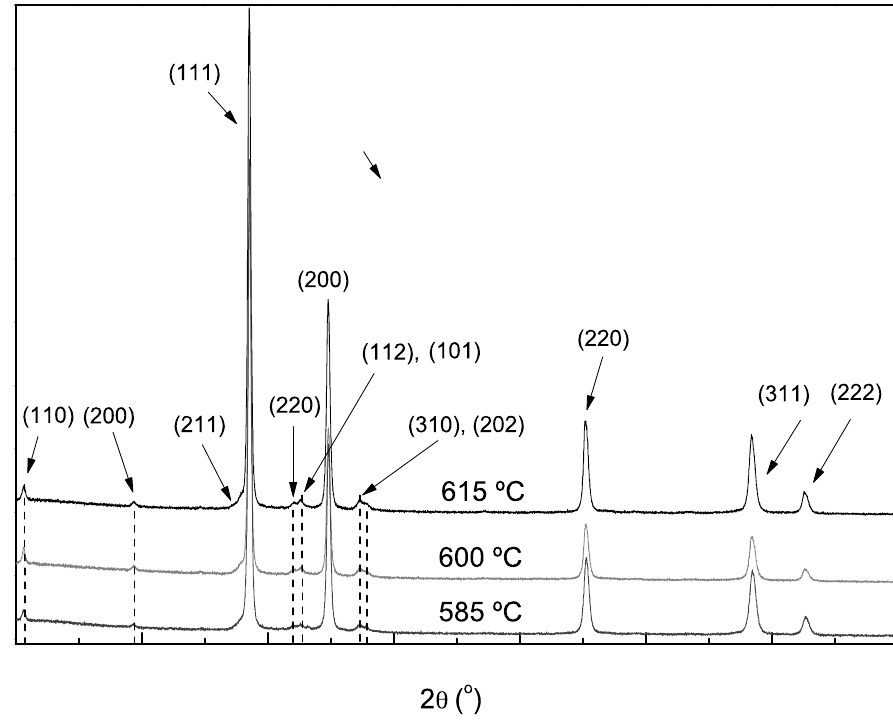
Figure 2. XRD patterns of the Al6Cu5Zn alloy at 0.5 h.